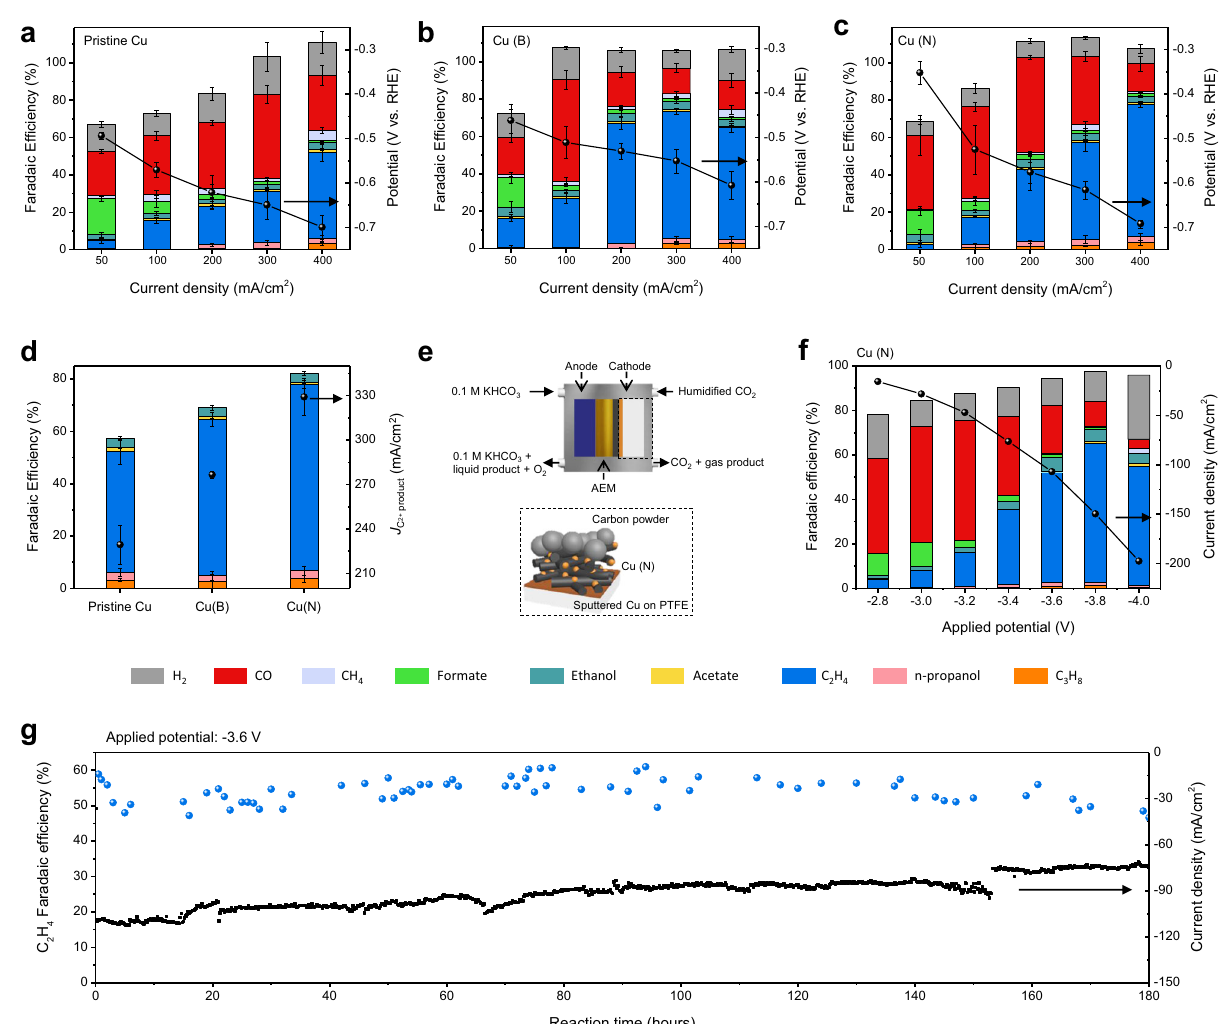
Fig. 4 Evaluation of CO 2 RR activity and stability by electrochemical measurements. Selectivity was measured in an alkaline fl ow cell through the galvanostatic method at j values from 50 to 400 mA/cm 2 . CO 2 RR activity comparison among the a pristine Cu, b Cu (B), and c Cu (N) samples in a fl ow cell with 1 M KOH as the electrolyte. d FE and partial current density for C 2 + products at 400mA/cm 2 . Error bar indicates the standard deviation of three independent measurements. e Schematics of MEA cell operation and the cathode con fi guration. f , g CO 2 RR performance of Cu (N) using the MEA cell in 0.1 M KHCO 3 as the electrolyte. f FE and current density at an applied potential from − 2.8 to − 4.0 V. g CO 2 electroreduction stability at an applied potential of − 3.6 V. C 2 H 4 selectivity and current density is displayed for 180 h of (C 3 H 8 : 3.7%; n-propanol: 3.2%; acetic acid: 0.7%; and ethanol: